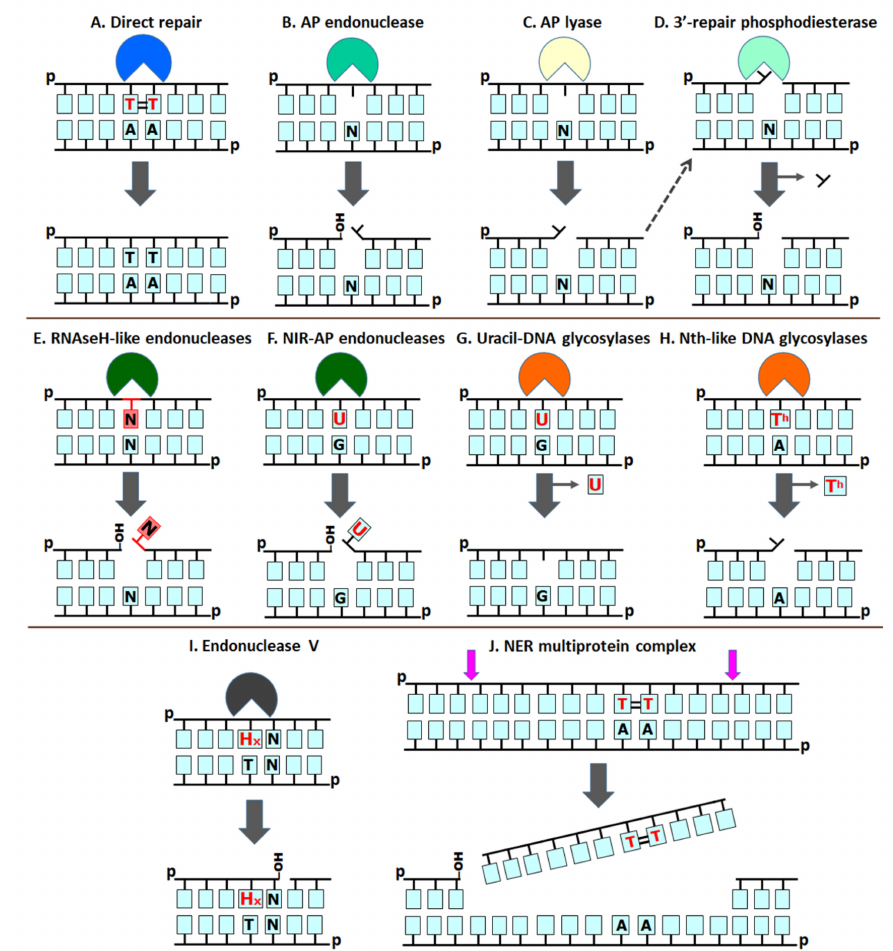
Figure 1. Principal DNA repair mechanisms employed by cellular organisms. ( A ) Direct repair of UV-induced pyrimidine dimer by a photolyase; ( B ) AP endonuclease-catalyzed cleavage of DNA at the 5’-side of an abasic site; ( C ) AP lyase cleaves DNA at the 3’-side of an abasic site; ( D ) 3’-repair phosphodiesterase and 3’-phosphatase remove a 3’-blocking moiety at DNA strand break generated by DNA glycosylases and free radicals; ( E ) RNAse H-like endoribonuclease cleaves a DNA-RNA duplex at the 5’-side of an RNA nucleotide; ( F ) NIR AP endonuclease cleaves DNA at the 5’-side of a 2’-deoxyuridine residue; ( G ) Uracil–DNA glycosylase removes uracil from DNA by hydrolysis of the N-glycosidic bond that links the base to the deoxyribosephosphate backbone, leaving an abasic site as the end product; ( H ) Nth-like bi-functional DNA glycosylases/AP lyases excise a pyrimidine hydrate in DNA and then cleave phosphodiester backbone at 3’-side of a remaining AP site; ( I ) Endonuclease V (Nfi) incises DNA at the second phosphodiester bond 3’ to a deaminated adenosine (hypoxanthine). ( J ) NER multi-protein complex removes a pyrimidine dimer in DNA by dual incision mechanism, in which the lesion is excised in the form of a short damaged nucleotides-containing single-stranded DNA oligonucleotide. N, deoxyribonucleotide; N with the red backbone, ribonucleotide; T h , thymine hydrate; U, uracil; Hx, hypoxanthine; T = T, UV induced pyrimidine